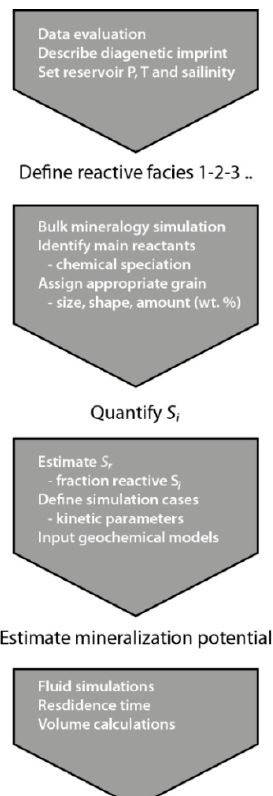
Figure 11. Workflow for estimating mineralization potentials specific to sedimentary facies and mineral occurrence in reservoir characterization.